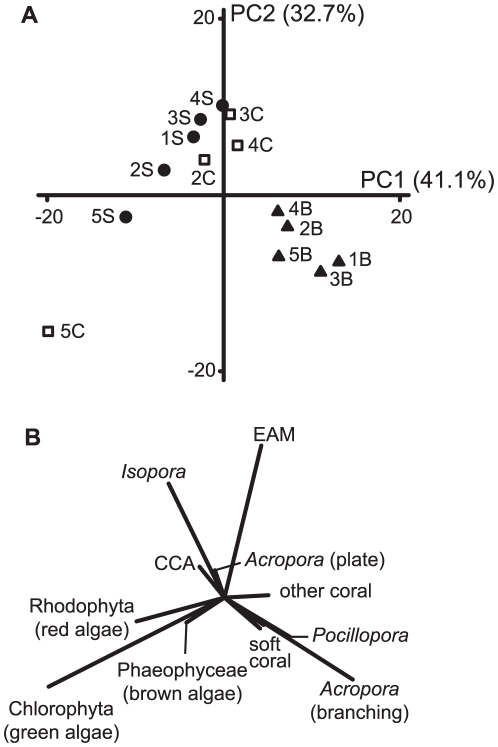
Principal component analysis showing the relationships among benthic assemblages on Lord Howe Island.(A) Ordination plot showing the relationship between fourteen locations. Each location is based on six 50-m point-intercept transects. Solid circles: reef slope locations; open squares: reef crest locations; solid triangles: back reef locations. Numbers refer to sites identified in Figure 1. (B) Substratum category loadings showing the relative contributions of each substratum to the observed differences in benthic community structure. CCA: crustose coralline algae; EAM: epilithic algal matrix.